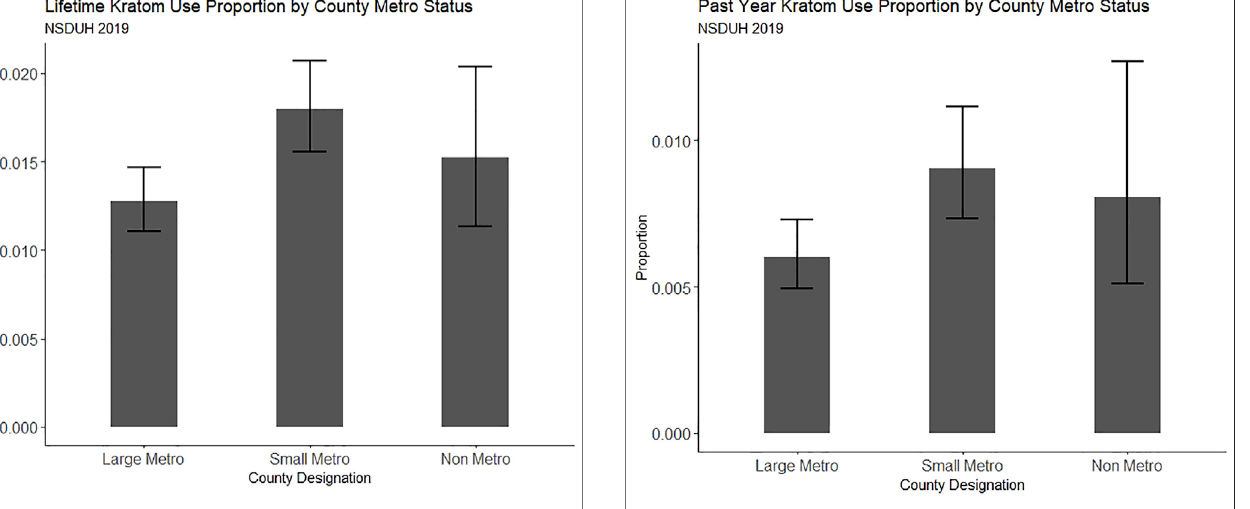
FIGURE 4 | Proportion of people reporting past-year kratom use in NSDUH 2019, split by county metro status. Error bars represent the estimate 95% con fi dence interval.